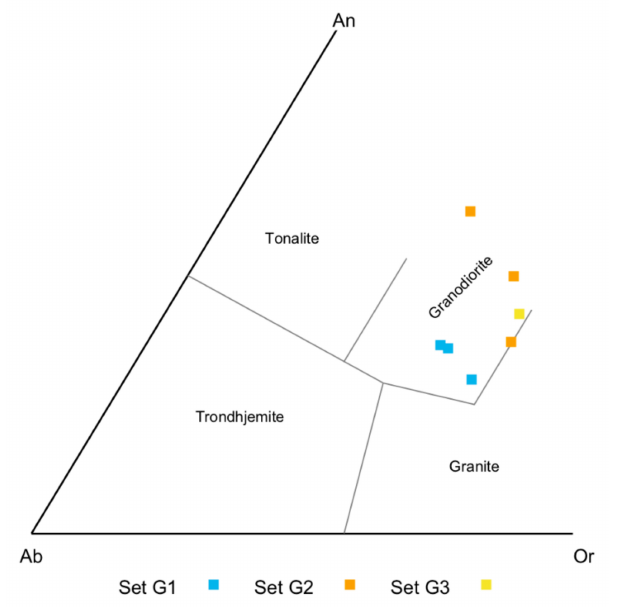
Figure 11. Quadrant of [29] granite classification with normalized feldspar endmembers. An: Anorthite, Ab: Albite, Or: Orthoclase.